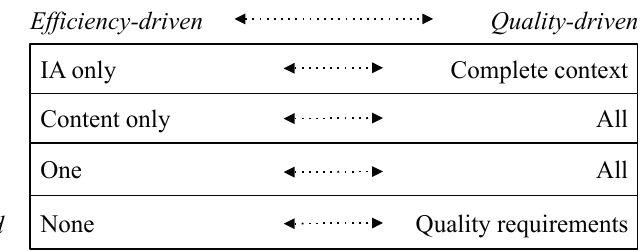
Figure 2. Connection strategy